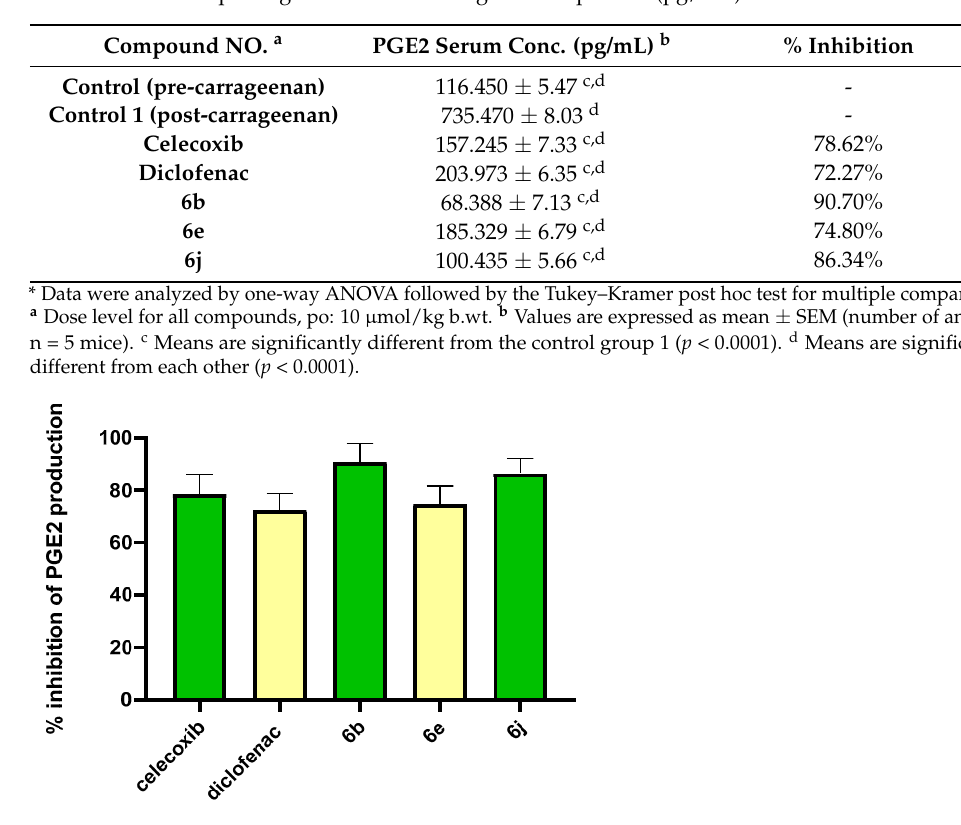
Figure 3. The % inhibition of rat serum prostaglandin E2 production after 8 h of injecting 10 µmol/kg b·wt of the tested compounds as well as celecoxib and diclofenac as positive controls.